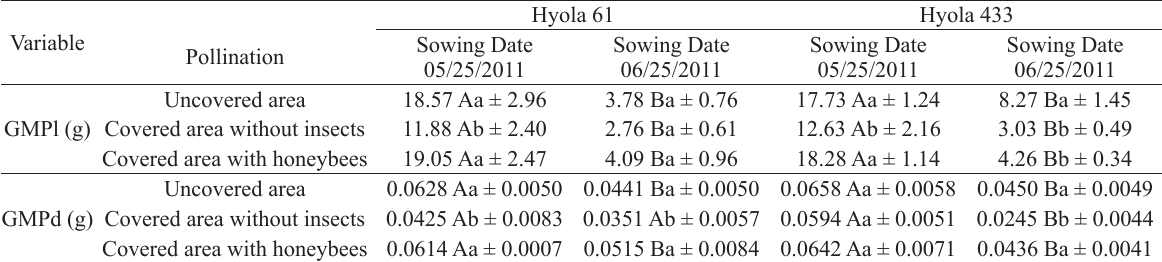
Mean and standard deviation values for grain mass per plant (GMPl) and grain mass per pod (GMPd) per pollination, hybrid and sowing date combination in Marechal Cândido Rondon (state of Paraná, Brazil).